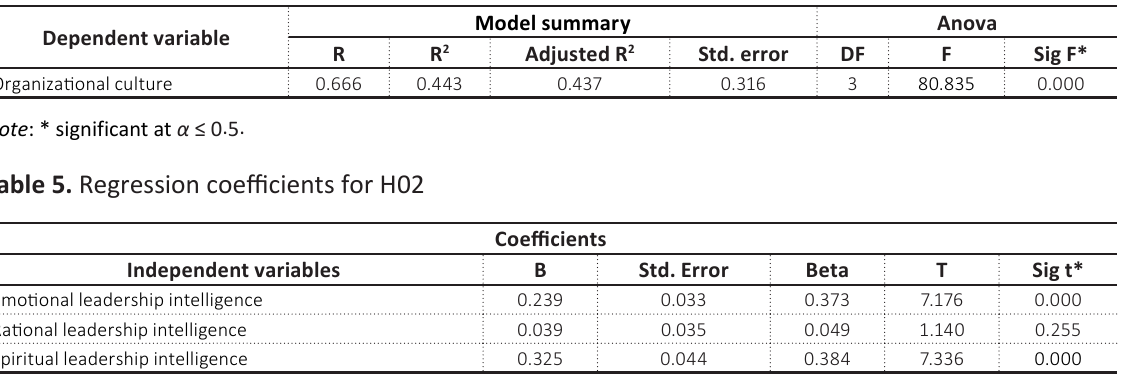
Table 4. Multiple linear regression for H02